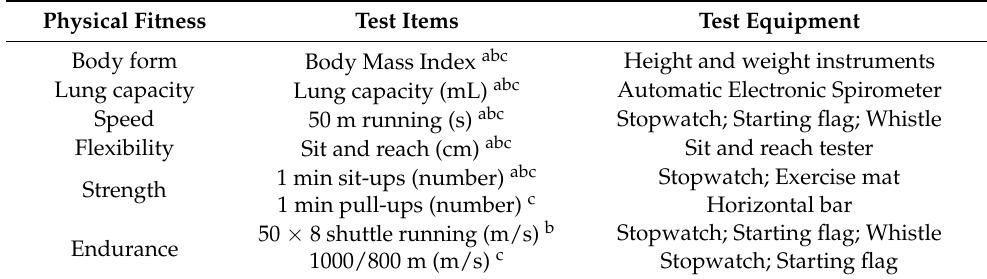
Table 2. List of test items and physical fitness